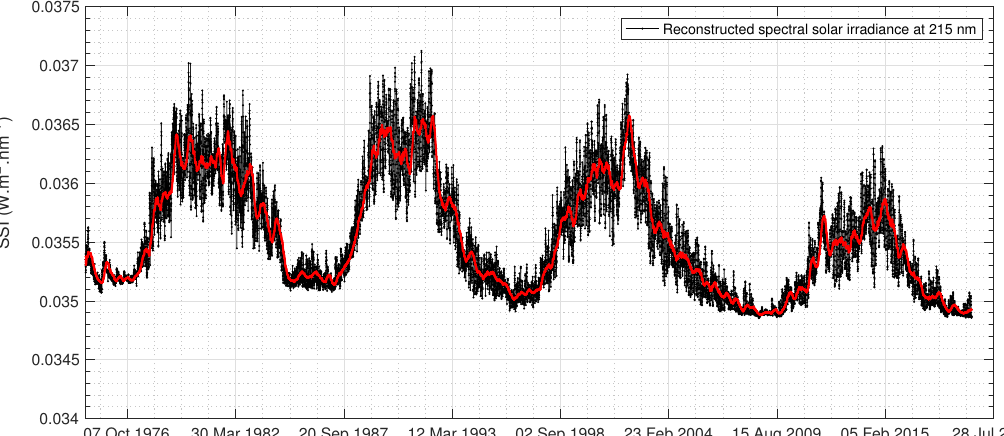
Figure 1. UV solar spectral irradiance at 215nm over the past 40 years from the SATIRE-S model. The relevant scientific goal is to be able to detect any long term trend with a target stability per decade of ± 3.4 10 − 5 Wm − 2 nm − 1 (Table 1) at 215 nm ( ∼ 1/10 of the expected trend (Figure 1) of